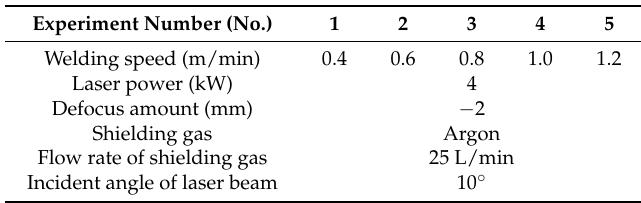
Table 2. Laser beam processing